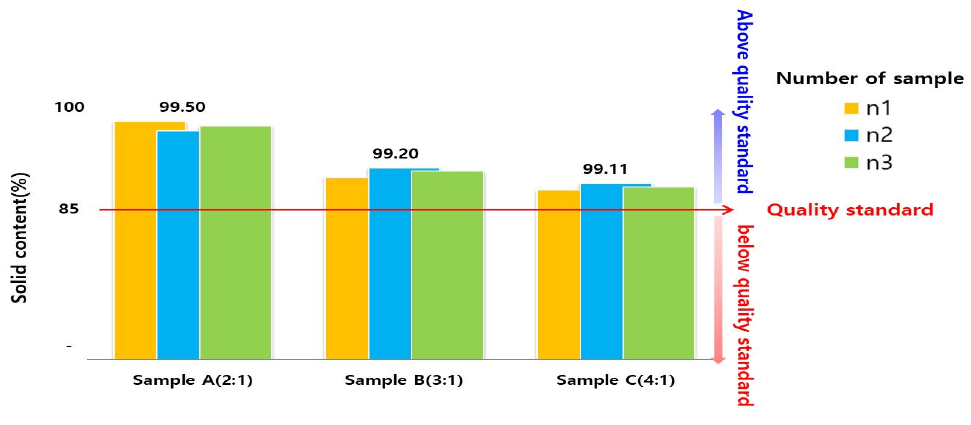
Table 5. Water permeability resistance by sample of W-SPRG.